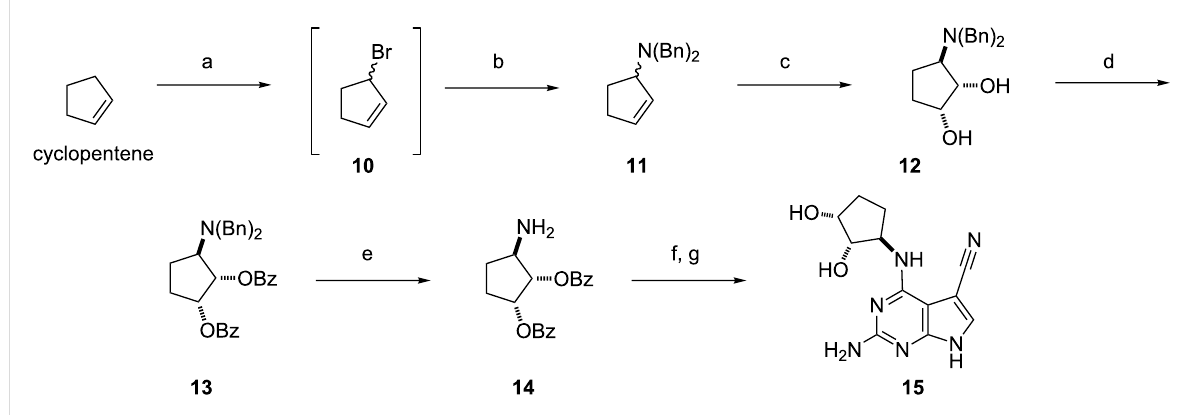
Figure 4: Synthesis of 15 , a (1 RS ,2 SR ,3 RS )-3-aminocyclopentane-1,2-diol derivative of PreQ 0 . Reagents and conditions: (a) NBS, (PhCO 2 ) 2 , CCl 4 , 1 h, 90 °C; (b) NH(Bn) 2 , CCl 4 , 12 h, rt, 70% (over two steps); (c) OsO 4 , NMO, acetone/H 2 O, 4 h, rt, 72%, 96% ds; (d) BzCl, pyr, 24 h, 0 °C to rt, 84%; (e) H 2 (1 atm), Pd(OH) 2 , EtOH/EtOAc, 16 h, rt, 98%; (f) 9 , Et 3 N, n -BuOH, 16 h, 130 °C; (g) KOH, n -BuOH/EtOH, 16 h, 80 °C,